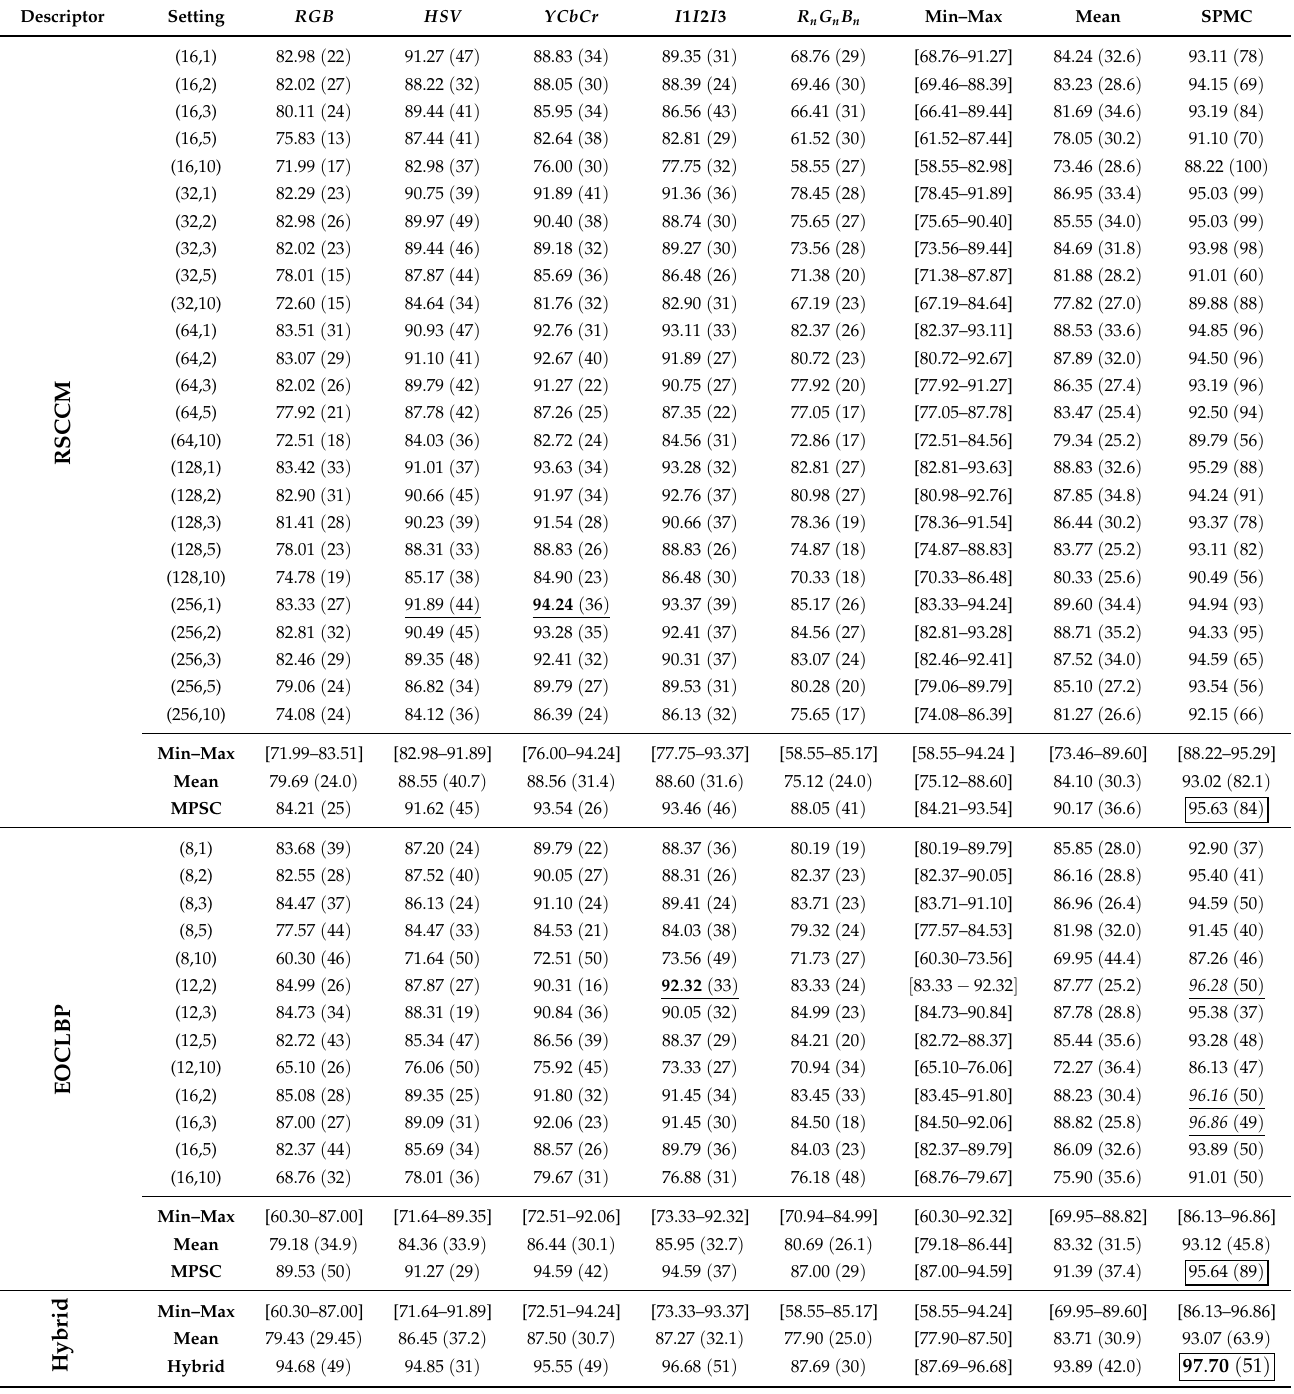
Table 4. Classification accuracy (in % of well-classified test images) for the USPtex dataset. For each descriptor, the best result reached by an SPSC representation is written in bold and underlined. The results obtained with MPMC and CHMCS representations are boxed (and bold written for CHMCS). Other italic and/or underlined annotations refer to other discussed